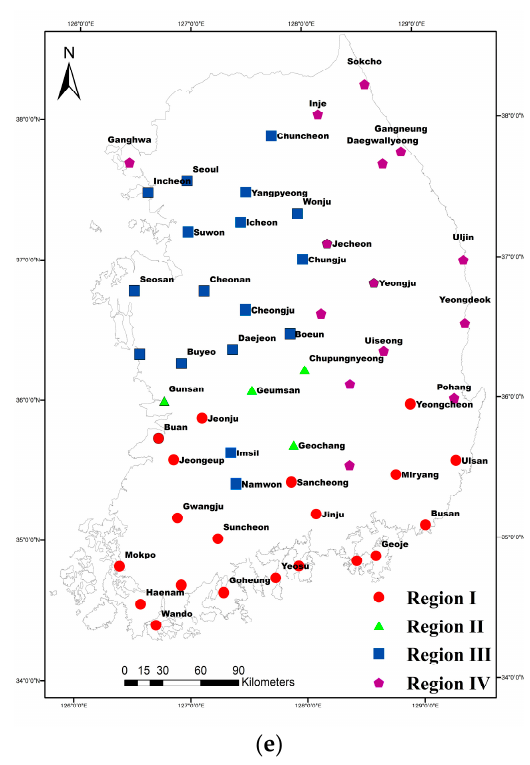
Figure 9. Spatial distribution of final delineated homogeneous regions for; ( a ) SPI-1; ( b ) SPI-3; ( c ) SPI-6; ( d ) SPI-12; ( e ) SPI-24.